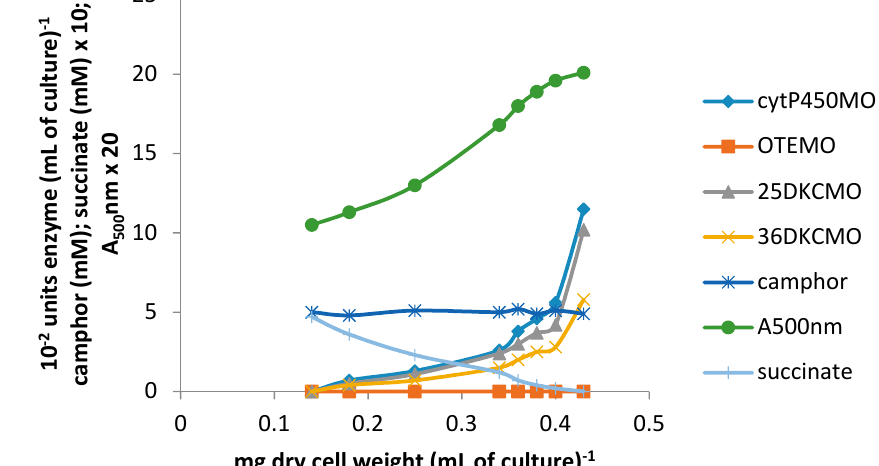
Figure 5. Changes in the optical density (A 500 nm) of a culture of P. putida NCIMB 10007 growing anaerobically following addition of ( rac )-camphor as inducer-substrate to succinate minimal medium supplemented with NaNO 3 and concomitant changes in the activity of key enzymes and metabolic intermediates of the camphor degradation pathway.